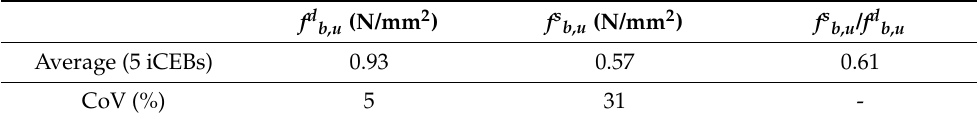
Table 5. Results of the three-point bending tests of the iCEBs.